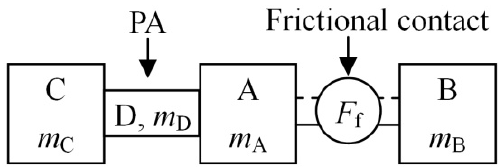
Figure 3. The general architecture of the PIFA system. A, B, C, D (PA): the objects in the system. m A , m B , m C : the masses of the objects. F f : the frictional force between object A and object B. PA: piezoelectric actuator.